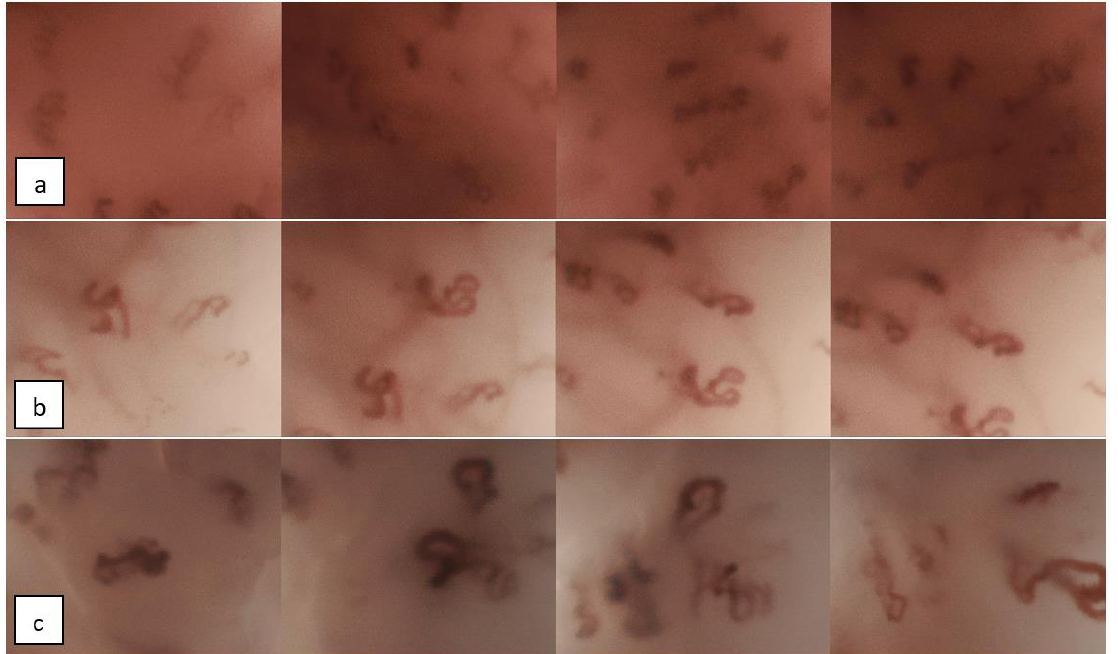
Figure 1. Examples of perpendicular vascular changes (PVC)-positive lesions: series of contact endoscopy with narrow-band imaging (NBI-CE) images depicting PVC. Histological diagnoses: ( a ) squamous cell carcinoma (SCC), ( b ) carcinoma in situ, and ( c ) papillomatosis. In all other cases, the lesions were declared PVC-negative (Figure 2a–c).